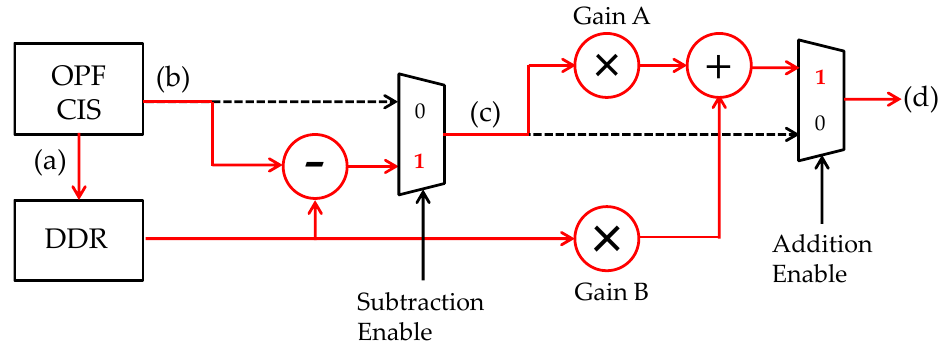
Figure 5. A signal flow diagram of the developed UV imaging system. (a) is the reference visible light background image. (b) is the UV image of interest overlapped on the VIS background image. (c) is the UV image extracted by subtracting (a) from (b). (d) is the synthesized image extracted by adding amplified (a) to amplified (c).